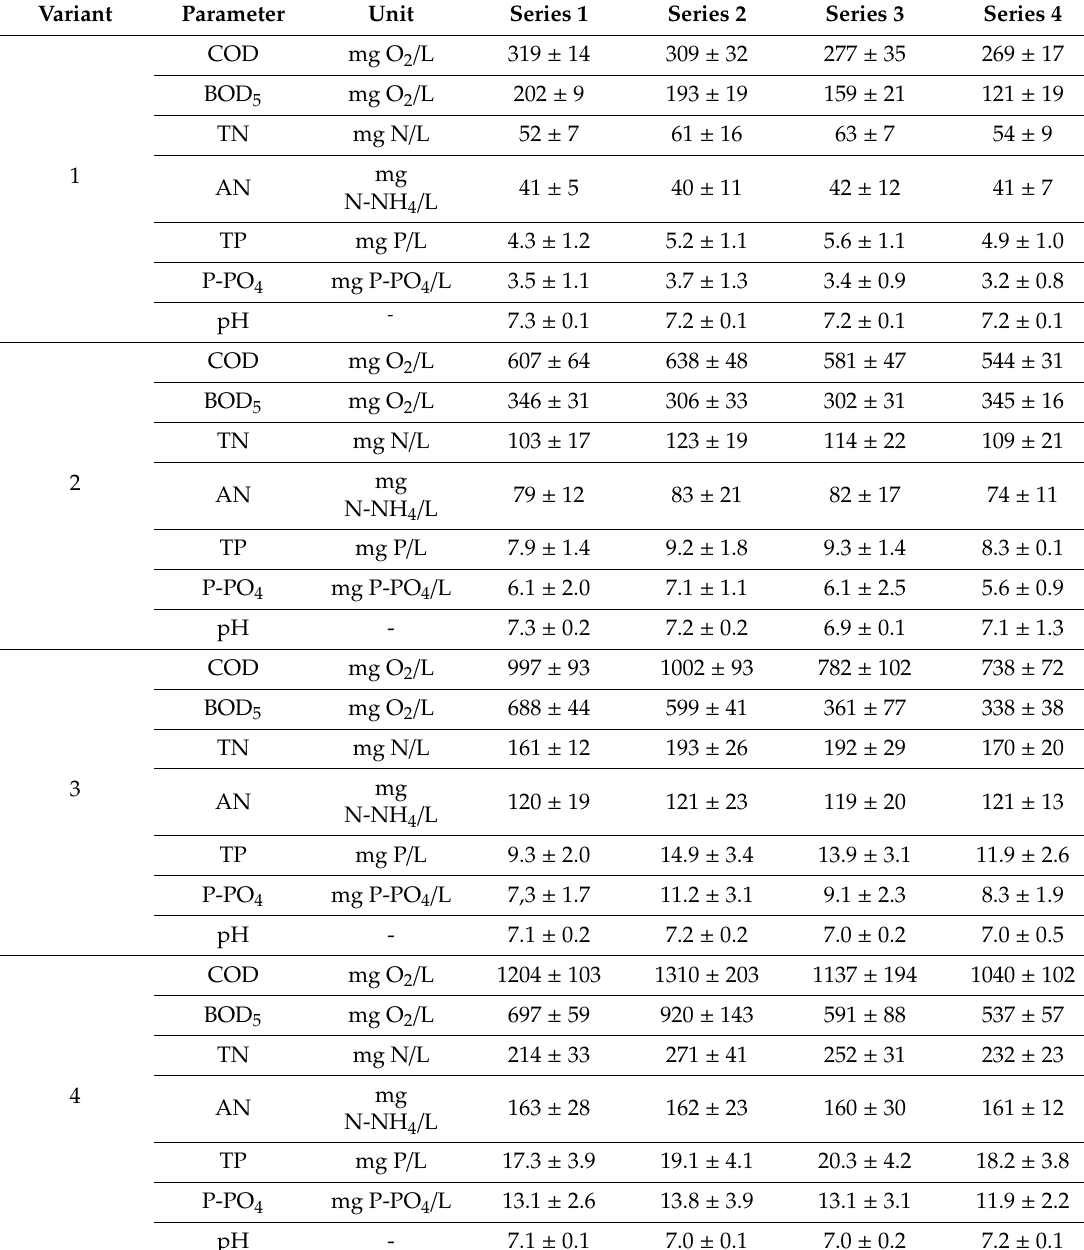
Table 3. The initial characteristics of the culture